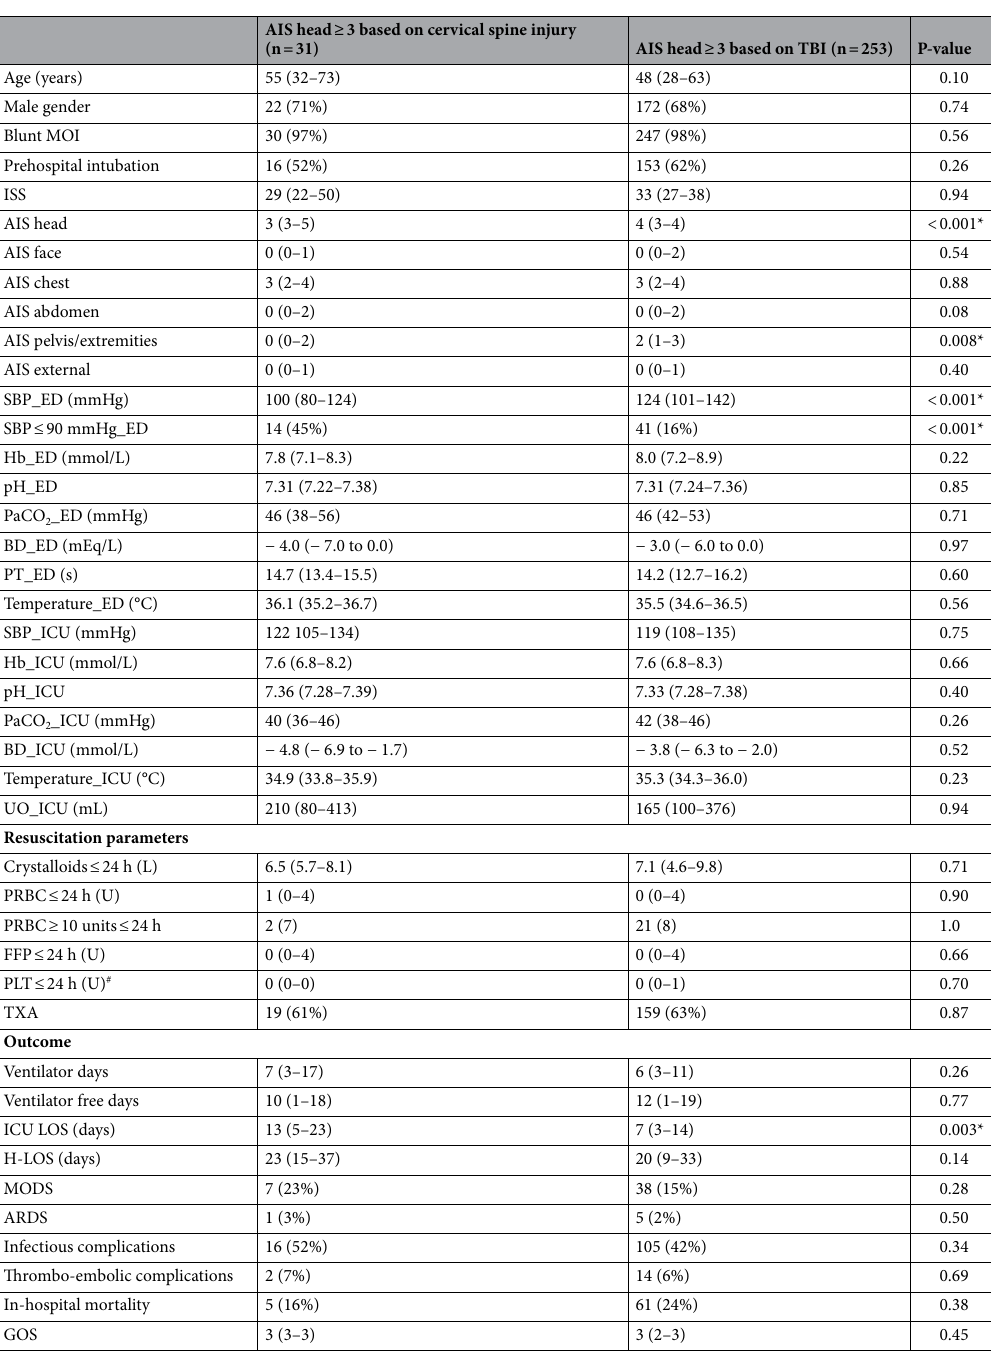
Table 1. Demographics in polytrauma with associated AIS head ≥ 3. Data are expressed as median (IQR) or absolute numbers (%). TBI traumatic brain injury, MOI mechanism of injury, ISS injury severity score, AIS Abbreviated Injury Scale, ED Emergency Department, SBP systolic blood pressure, Hb hemoglobin, PaC02 partial pressure of carbon dioxide in arterial blood, BD base deficit, PT prothrombin time, UO urinary output first hour in ICU, PRBC packed red blood cells, FFP fresh frozen plasma, PLT platelets, TXA tranexamic acid, LOS length of stay, MODS multiple organ dysfunction syndrome, ARDS adult respiratory distress syndrome, GOS Glasgow Outcome Score. *statistically